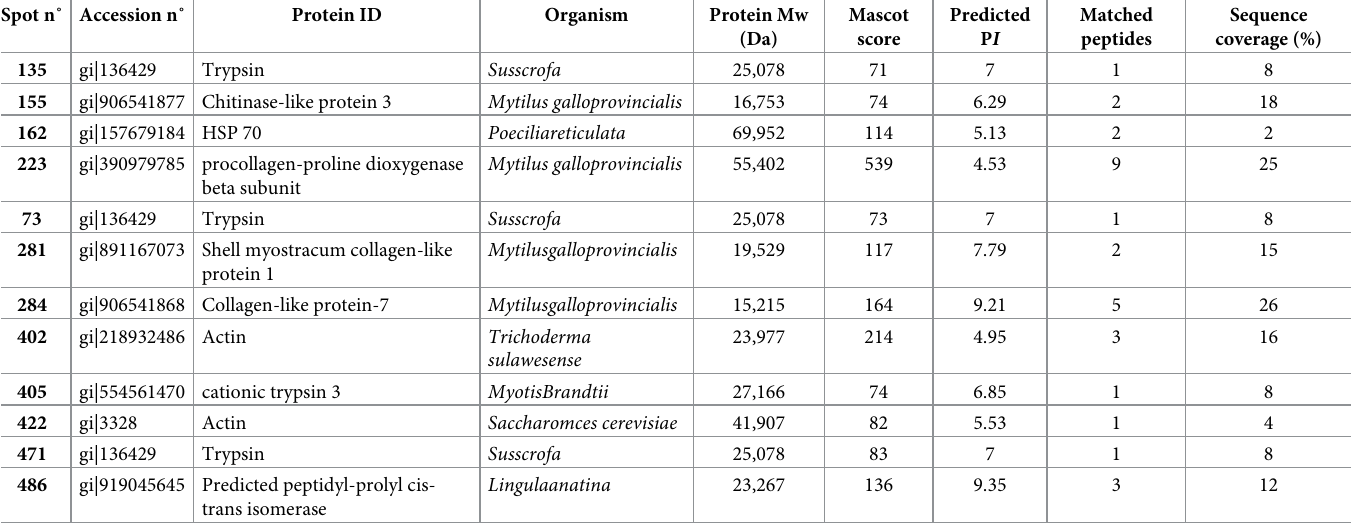
Table 2. Identified proteins using MALDI